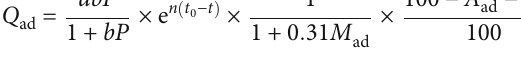
Figure 6: Average small pore fractal dimension of di ff erent metamorphism